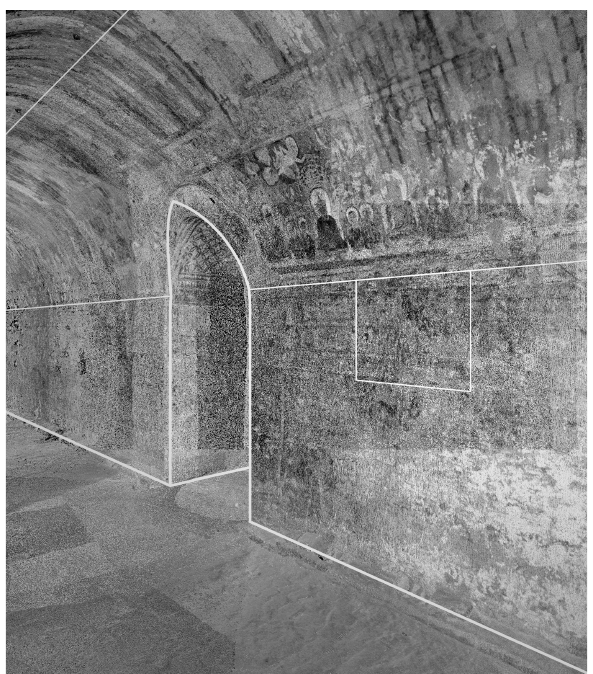
Figure 13. Photogrammetry orthophoto with condition assessment in BIM of west wall